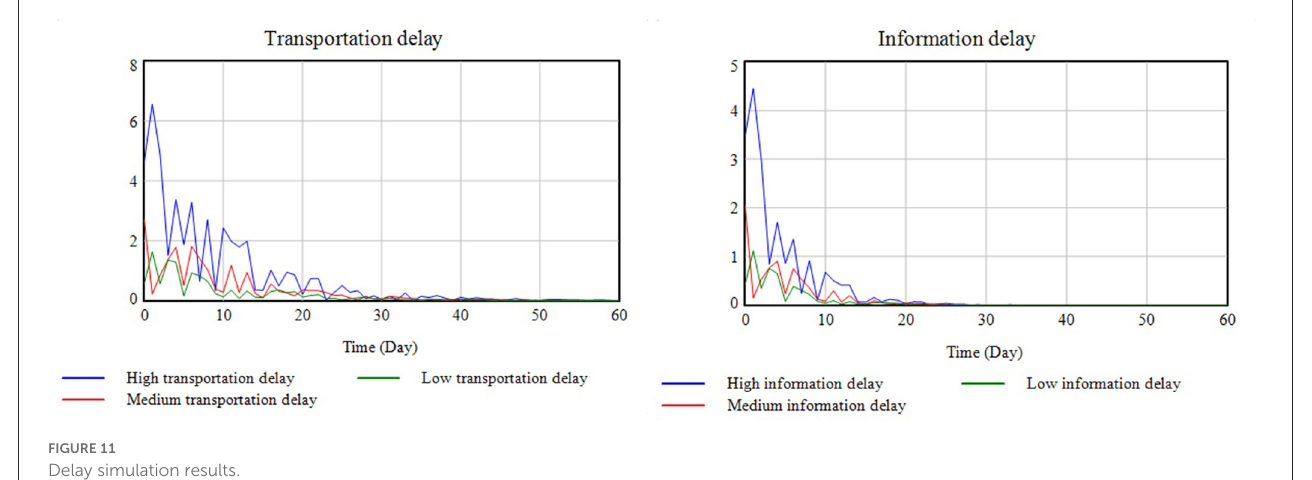
FIGURE11 Delay simulation